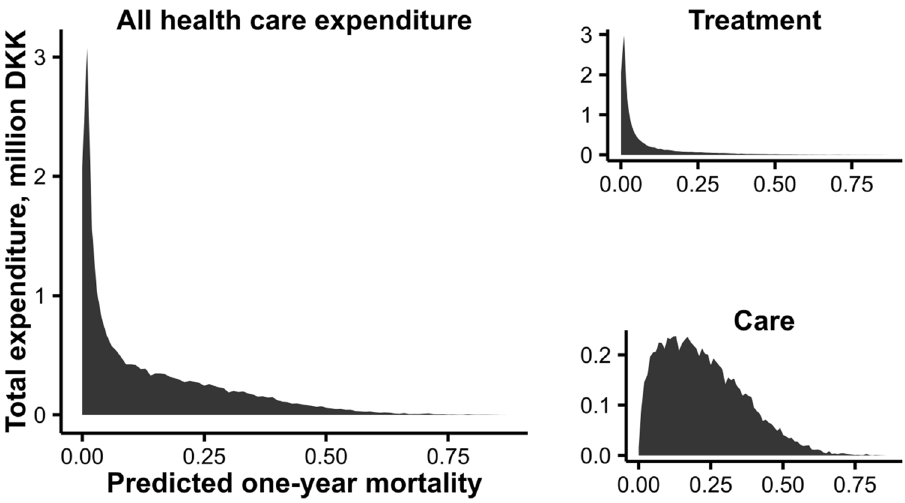
Figure 4. Healthcare expenditure by predicted one-year mortality expenditure and type of